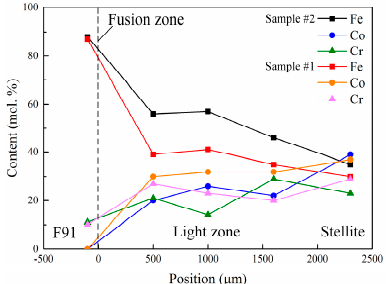
Figure 6. Element distribution perpendicular to fusion line of samples #1 and